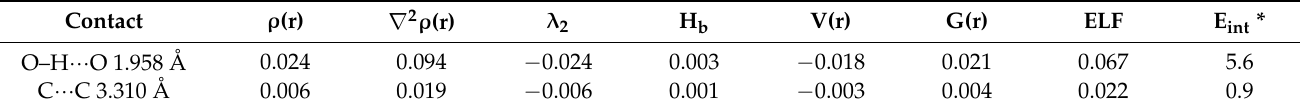
Table 4. Values of the density of all electrons— ρ ( r ), Laplacian of electron density— ∇ 2 ρ ( r )